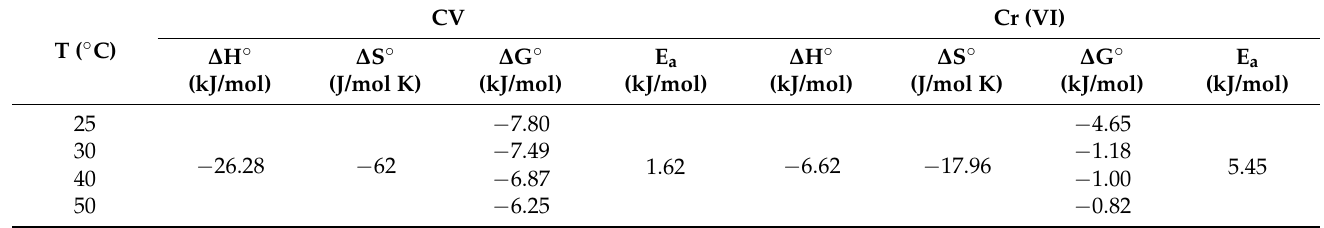
Table 8. Comparison of ACSCGs’s adsorption capacity with other activated carbons.